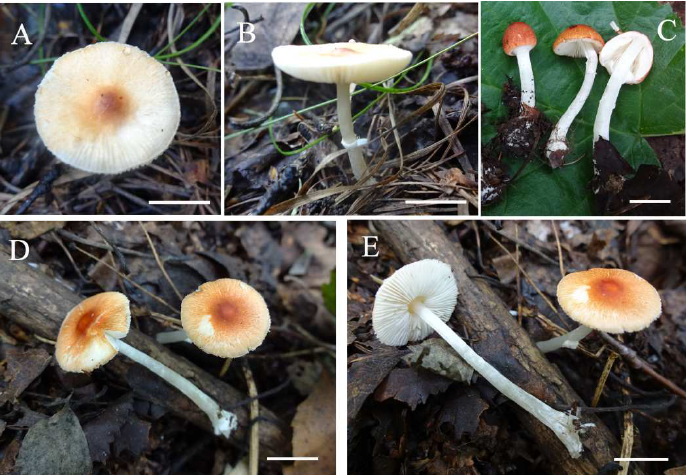
Figure 6. Basidiomata of Leucoagaricus aurantioruber . ( A , B ) CFSZ 18372; ( C – E ) CFSZ 19756). Scale bars: 1 cm.